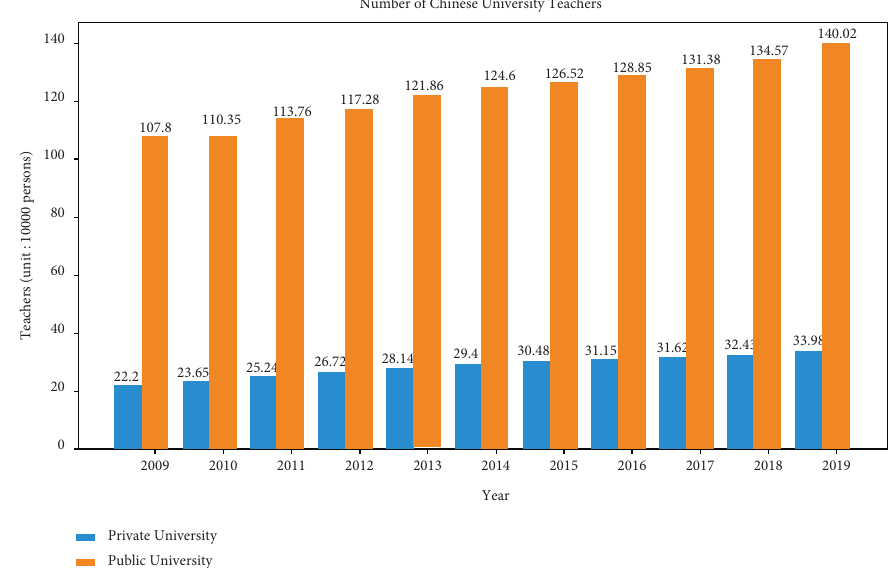
Figure 2: The number of Chinese public university teachers and private university teachers. Note: the data are from the website of the Chinese National Statistical Bureau: